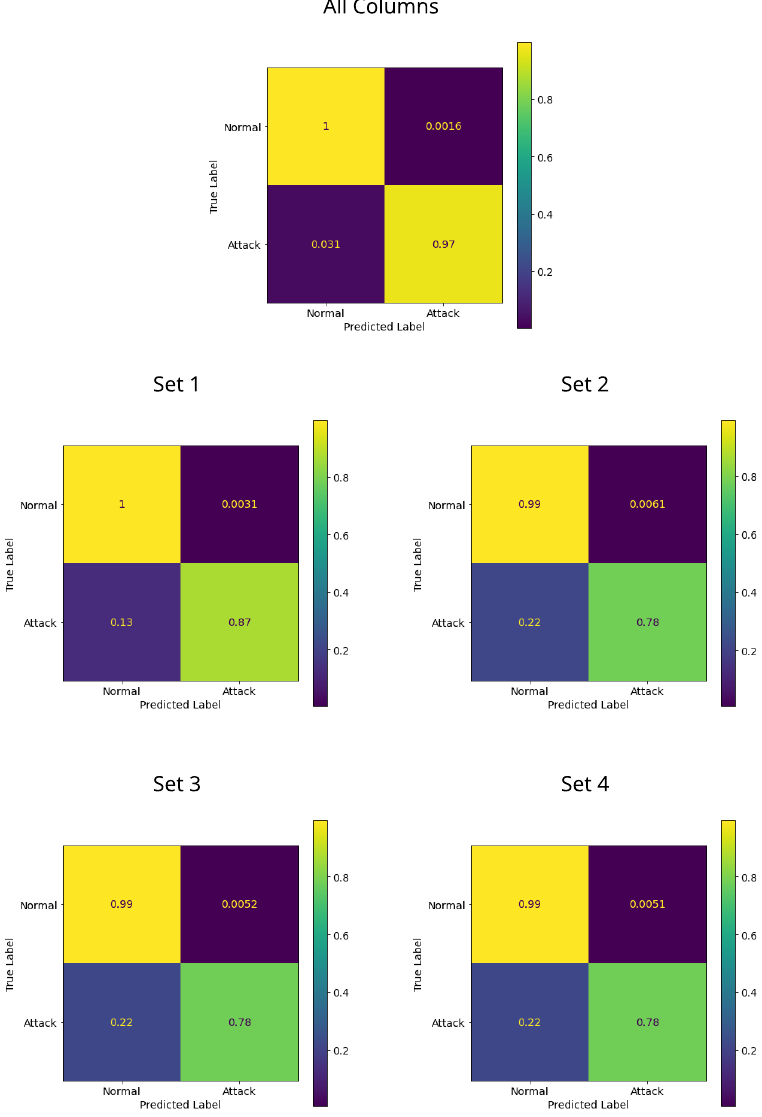
Figure 12. Confusion matrices with validation